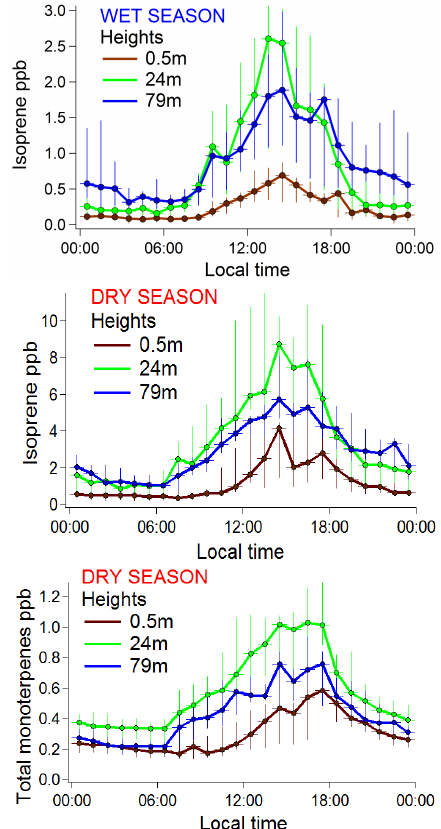
Figure 4. Diurnal hourly medians of isoprene during the wet sea- son (top), isoprene during the dry season (middle) and the sum of monoterpenes during the dry season (bottom) (wet season data for monoterpenes are below LOD and not reported). Range bars repre- sent the 25 and 75% percentiles.